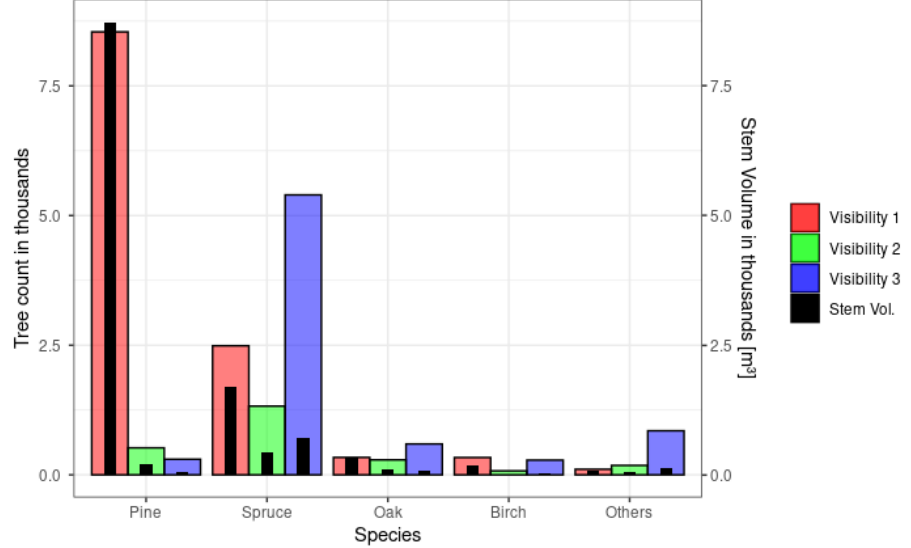
Figure 2. Comparison of field tree count of each species in the analyzed stands distinguishing by their visibility in the context of stem